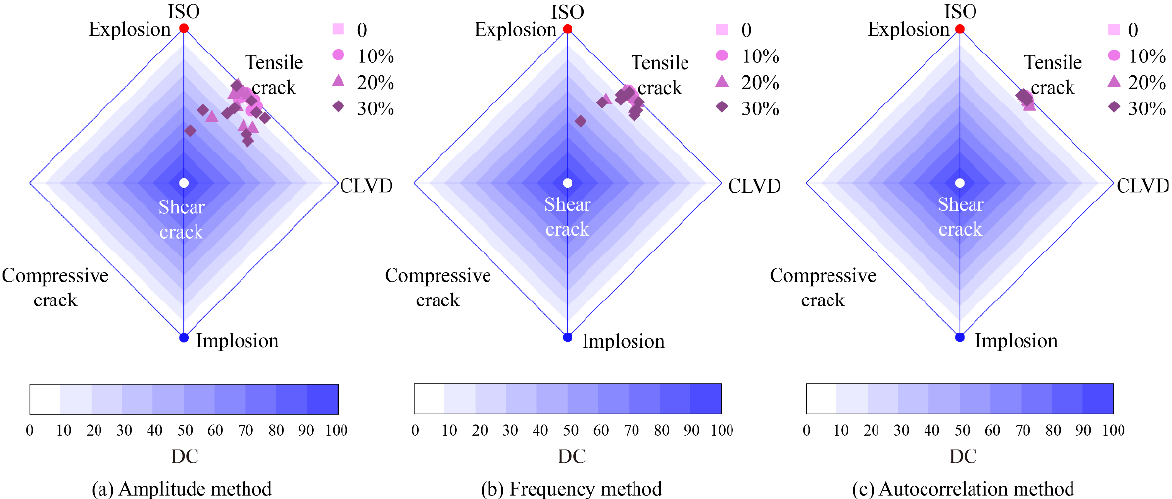
Figure 6. The source-type plots of the inversion results for the three methods for pure tensile cracks. The symbols of different shapes represent the results of different noise levels. The locations of symbols are determined by the proportions of three basic tensors (ISO, DC and CLVD) and the proportions are calculated by the decomposition of moment tensors.